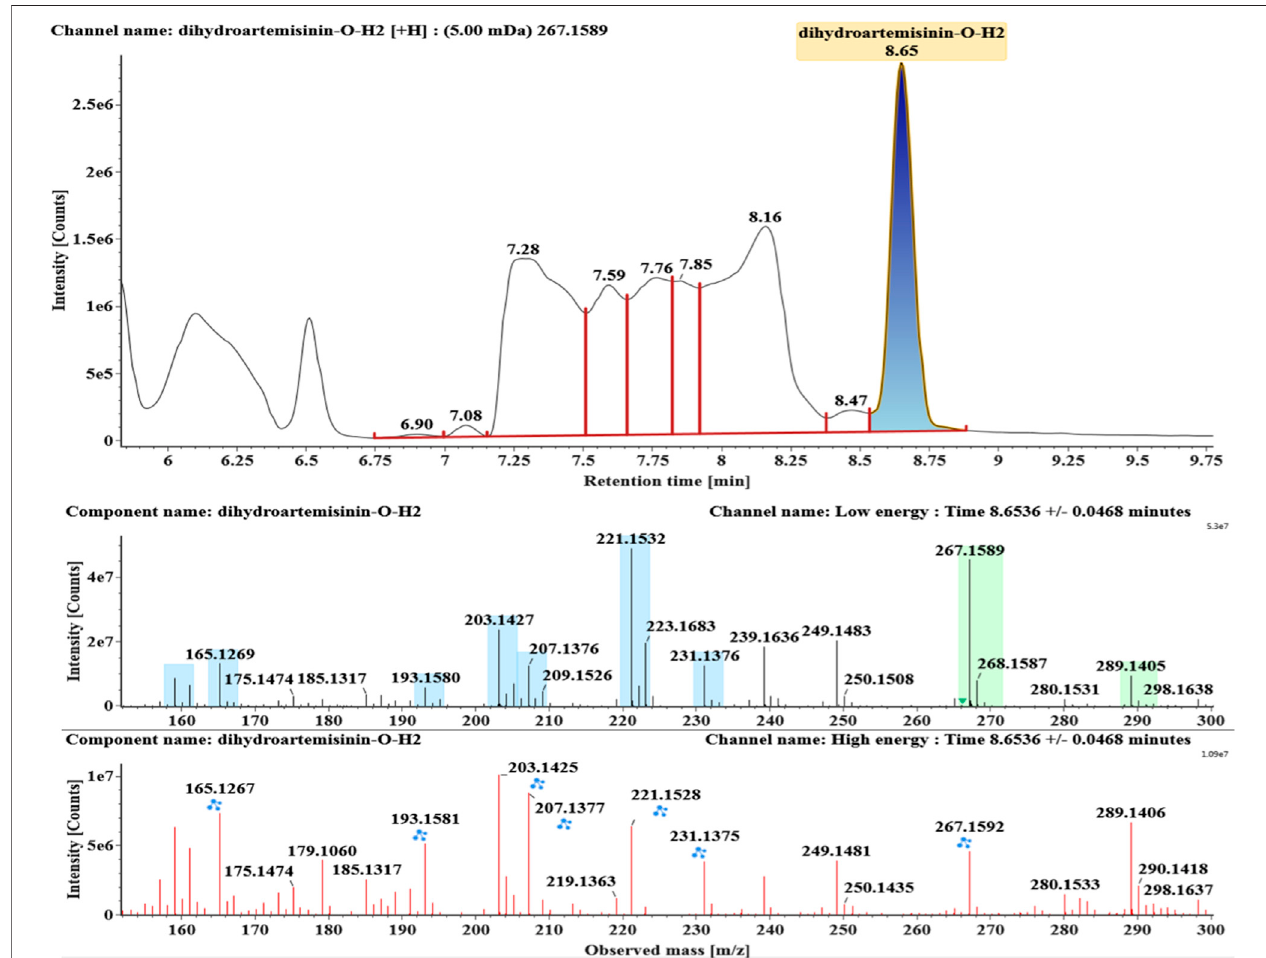
FIGURE 10 | Extracted ion chromatograms and mass spectrometry (MS E ) spectra of M9 .